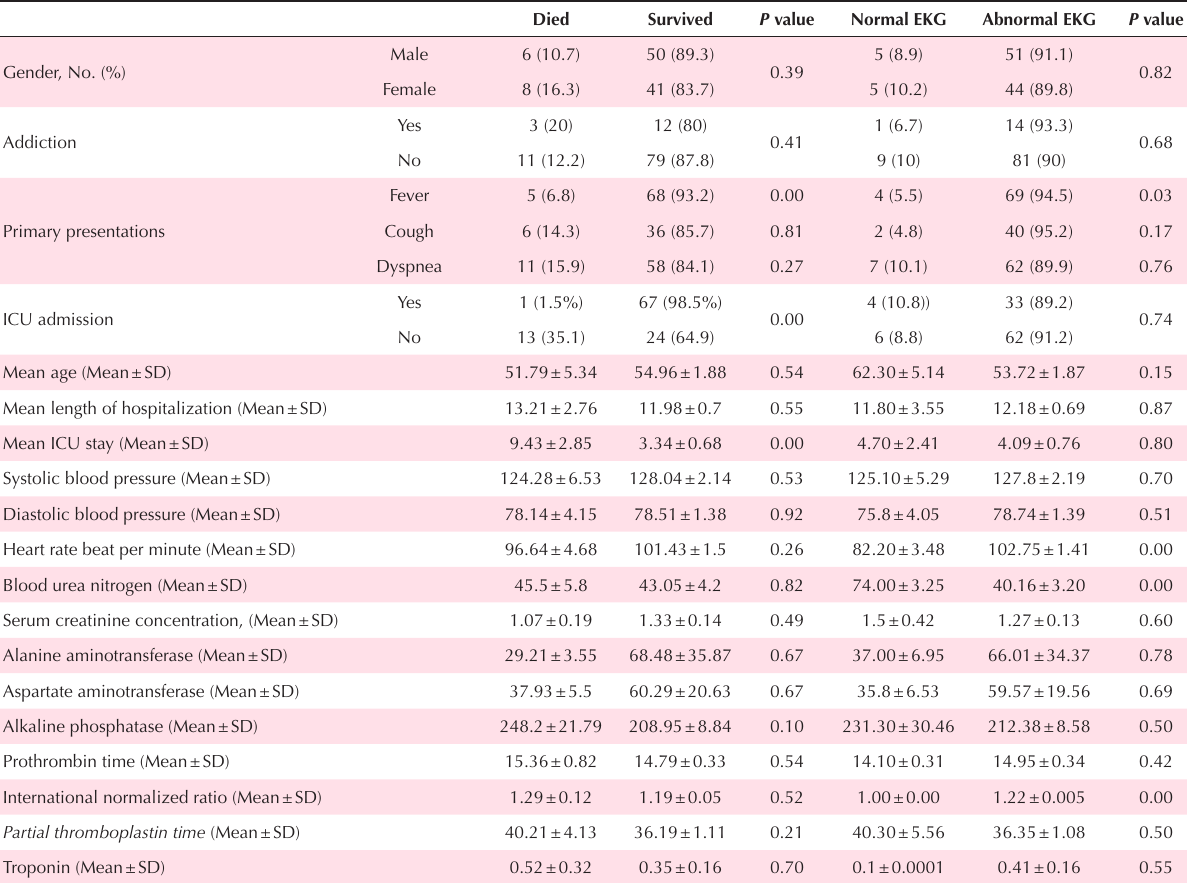
Table 1. Comparison of demographics and laboratory findings by prognosis and ECG